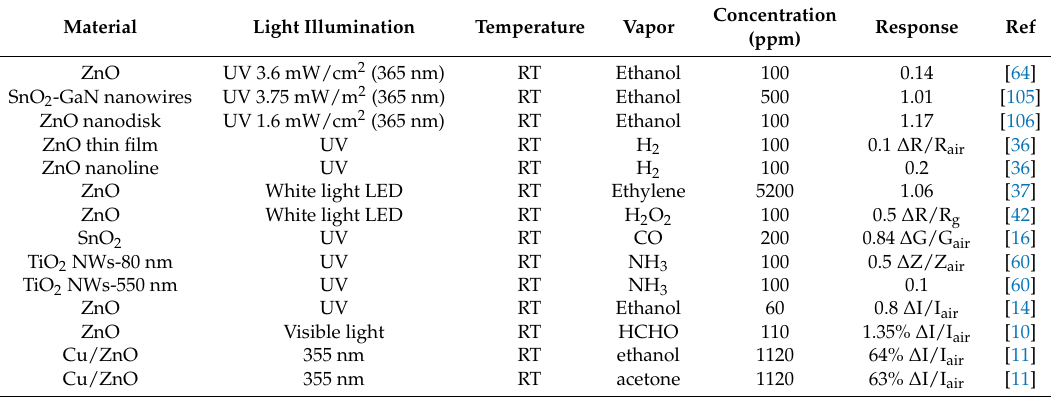
Table 6. Summary of response of light-activated sensors operated at room temperature. (The response is defined as the ratio between R a and R g : R a /R g if there is no special definition in the table. ∆ R, ∆ G, ∆ I is the absolute value of change of resistance, conductance and current